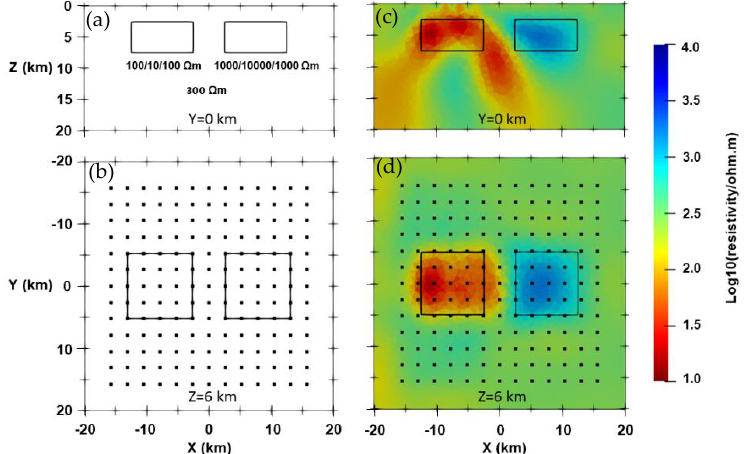
Figure 10. Panels ( a ) and ( b ) show the true model at y = 0 km and z = 6 km. Panels ( c ) and ( d ) show the isotropic inversion results at y = 0 km and z = 6 km. The black dots represent MT receivers. The size of the whole simulation domain for the forward modeling and inversion are both 200 km × 200 km × 100 km. The domain extends from − 100 km to 100 km in the horizontal direction and from − 20 km to 80 km in the vertical direction. The mesh for forward modeling is discretized into 834,627 cells. For the inversion, the mesh in the inversion domain is discretized into 188,389 cells, and the total number of mesh is 417,504. The inversion domain extends from − 20 km to 20 km in the horizontal direction and from 0 km to 20 km in the vertical direction. The initial and reference models are set to be 100 Ωm homogeneous half-space. The standard error is set to be 0.02 ∙ 𝑠𝑞𝑟𝑡(|𝑍 𝑥𝑦 ∙ 𝑍 𝑦𝑥 |) . The roughness matrix is calculated by the 20 surrounding elements of each cell. The maximum number of inversion iterations is set to 10, and the threshold RMS for the inversion is 1.05.